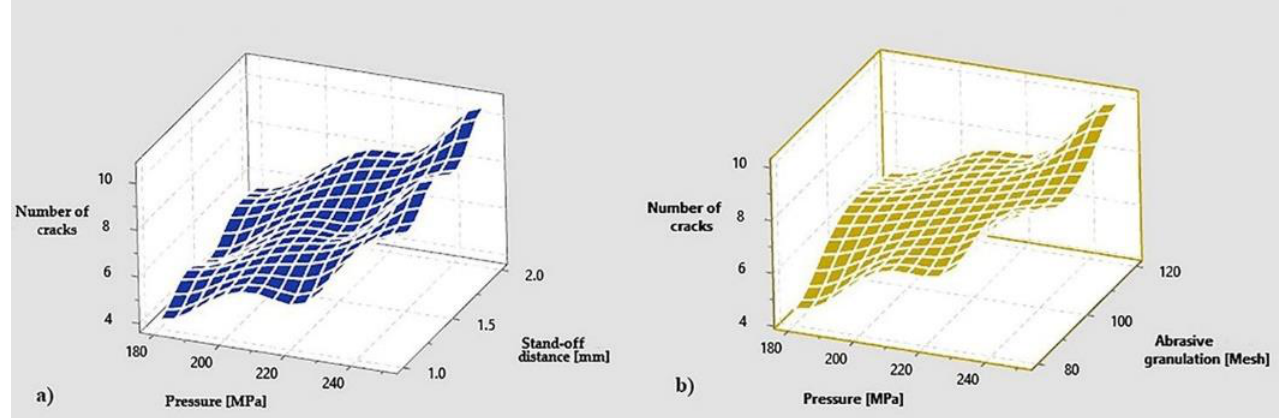
Figure 6. Dependence of number of cracks on: ( a ) pressure and stand-off distance; ( b ) pressure and abrasive granulation.